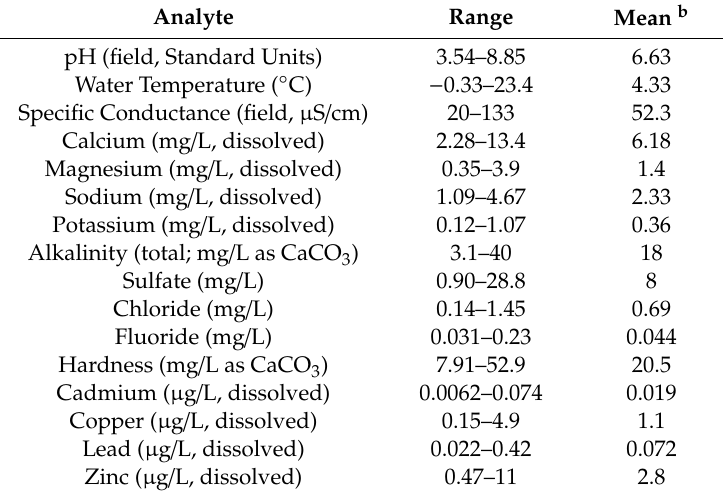
Table 2. Water quality data, South Fork Koktuli River, Mine Site a